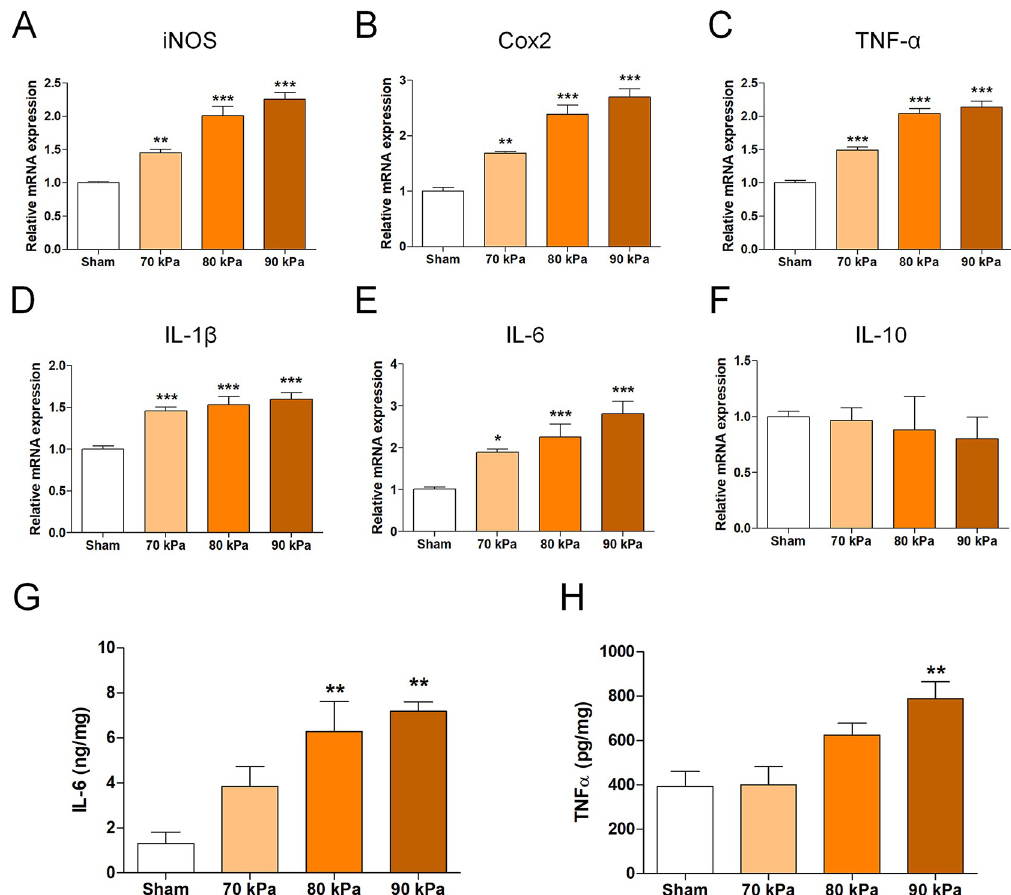
Fig 4. Inflammation-related gene expression in the LSS model. (A–F) Relative mRNA levels of pro- and anti-inflammatory enzymes and cytokines: (A) iNOS , (B) Cox2 , (C) TNF- α , (D) IL-1 β , (E) IL-6 , and (F) IL-10 in spinal cords implanted with a silicone block (n = 6 per group). (G, H) Enzyme-linked immunoassay results for inflammatory cytokine production. (G) IL-6, (H) TNF- α in each group 1 week after implantation of the silicone block (n = 6 per group). Data are expressed as the means ± SEM. � P < 0.05, �� P < 0.01, and ��� P < 0.001 compared with the sham group analyzed by a one-way ANOVA with Tukey’s post-hoc